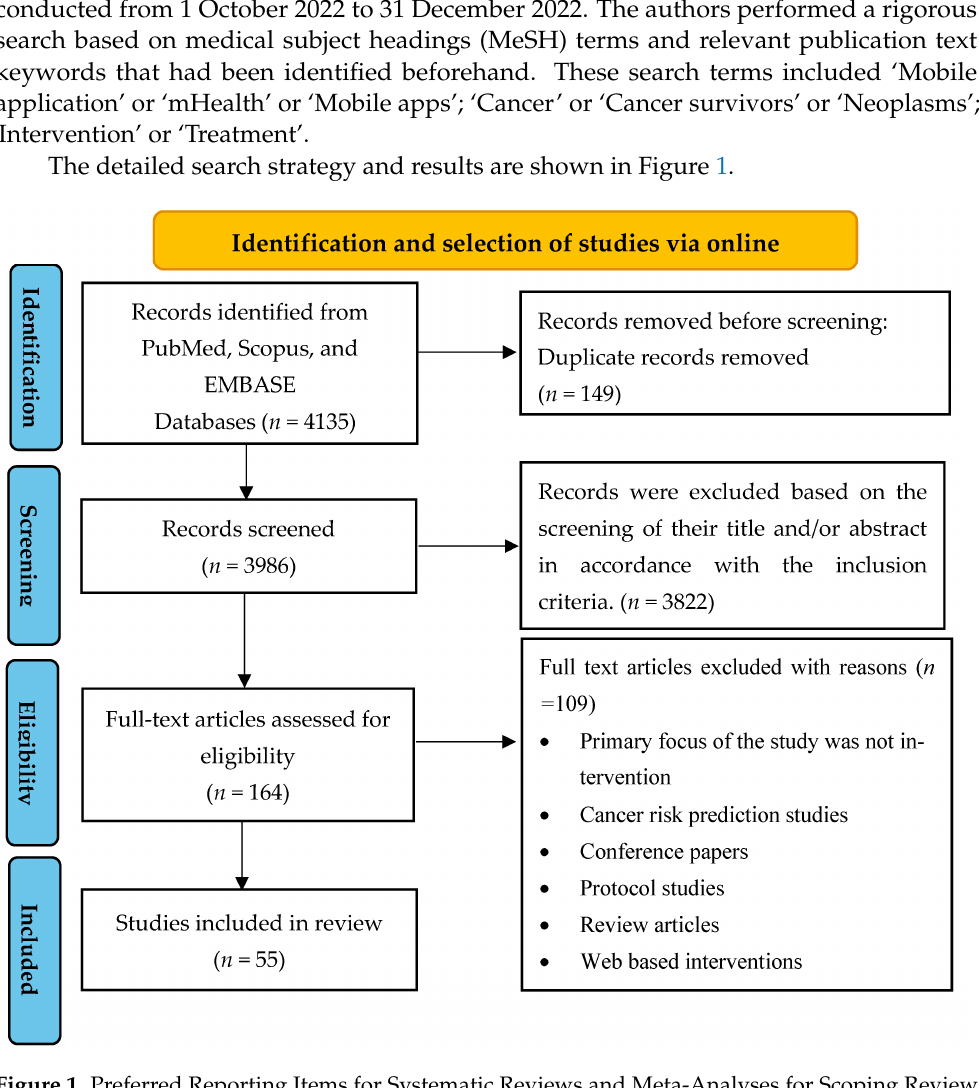
Figure 1. Preferred Reporting Items for Systematic Reviews and Meta-Analyses for Scoping Review (PRISMA-ScR) fl ow chart of study identi fi cation and selection of studies.